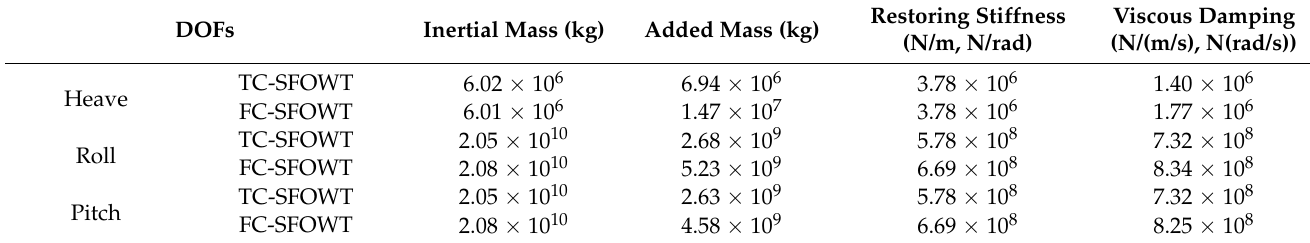
Table 5. Viscous damping for